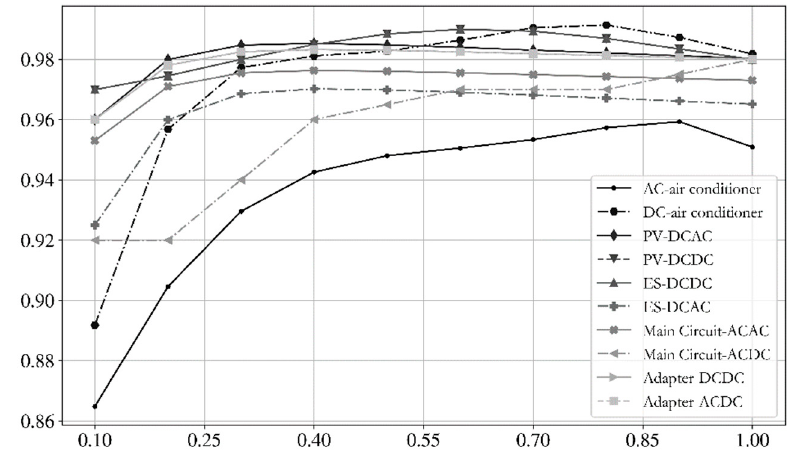
Figure 3. Conversion efficiency of converters in different operating conditions.